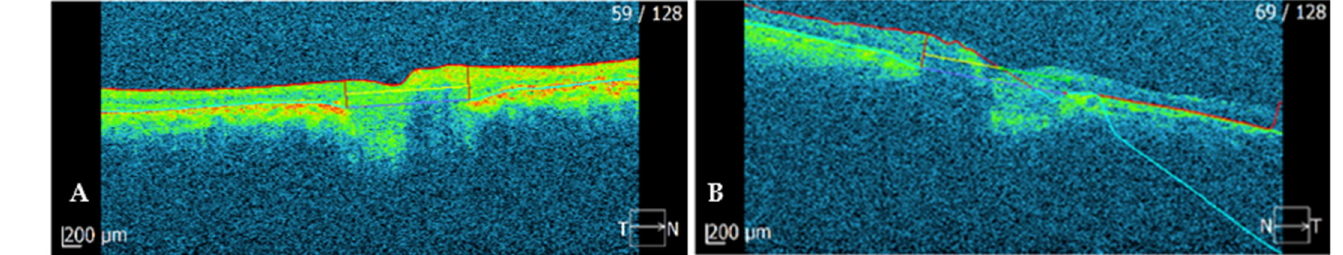
Figure 1. ( A ) SD-OCT image of the macula of the right eye; ( B ) SD-OCT image of the macula of the left eye.